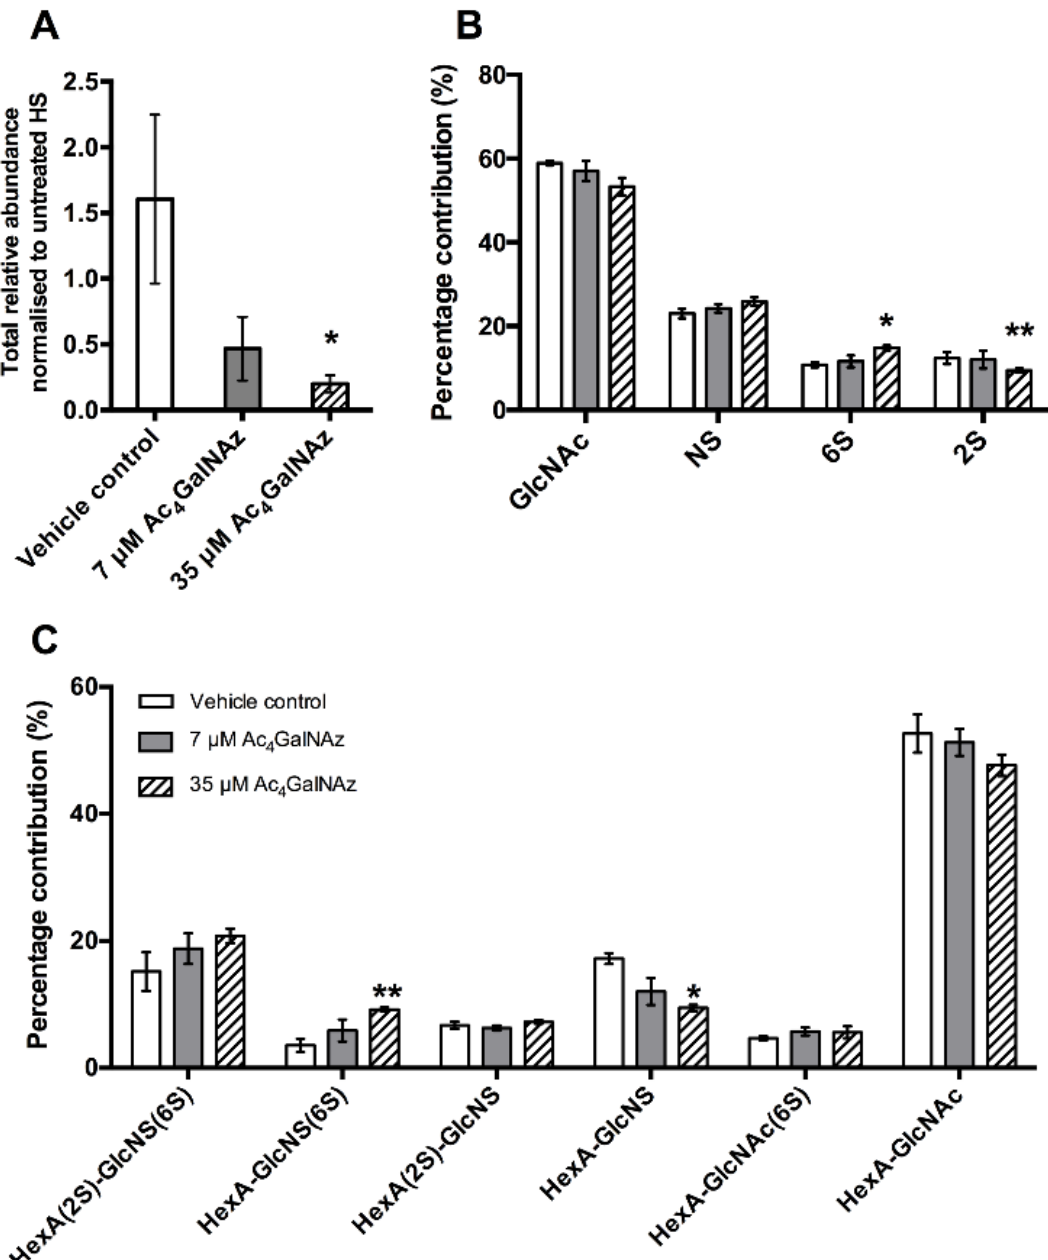
Figure 3. ( A ). Total relative abundance of HS from cell extracted samples. ( B ) Percentage chemical modification